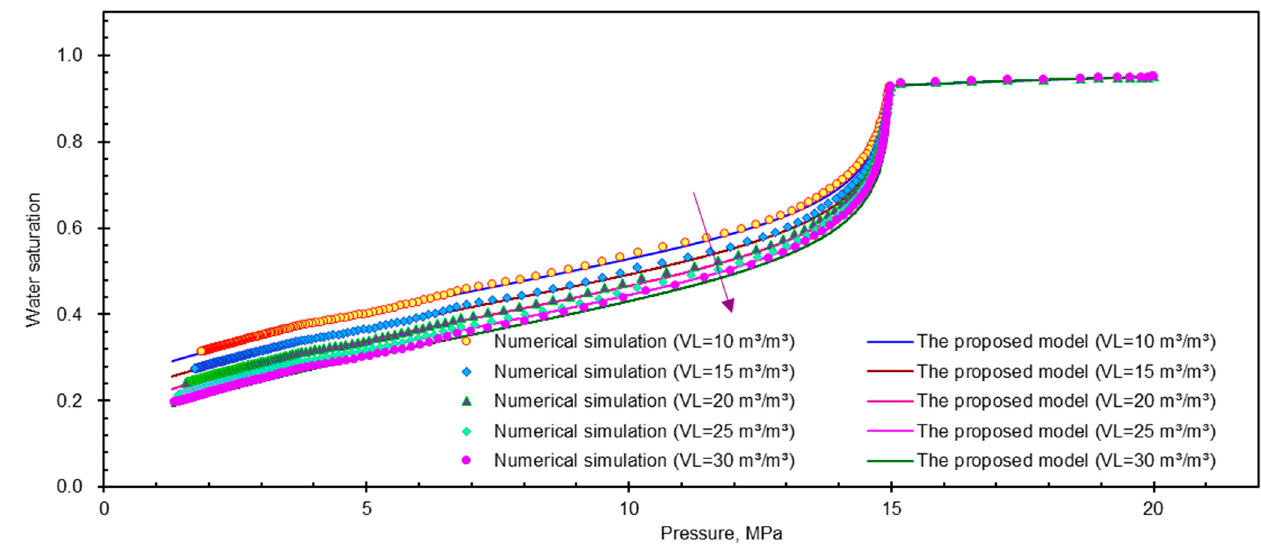
Figure 5. Comparison of calculation results of the proposed method considering different Langmuir volumes.